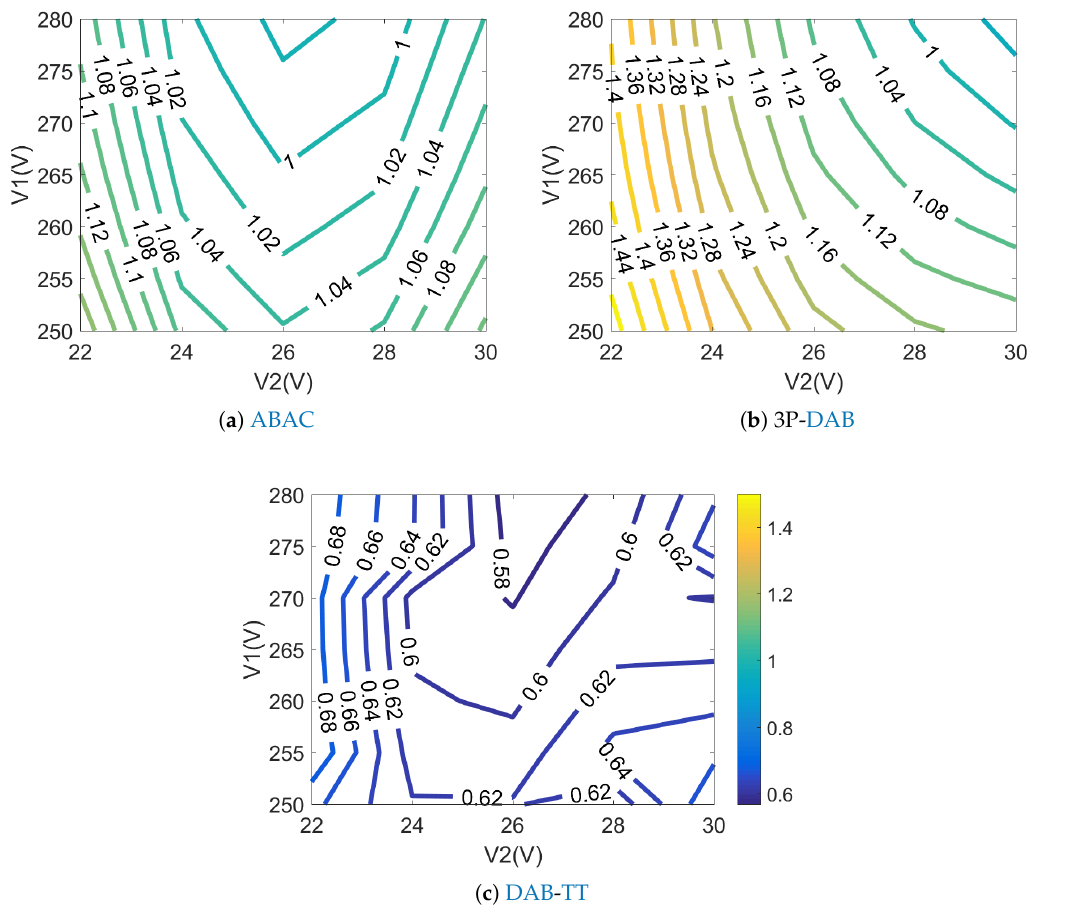
Figure 6. Magnetic losses in % (magnetics losses divided by converter transferred power) for all the operating points at nominal power and 100